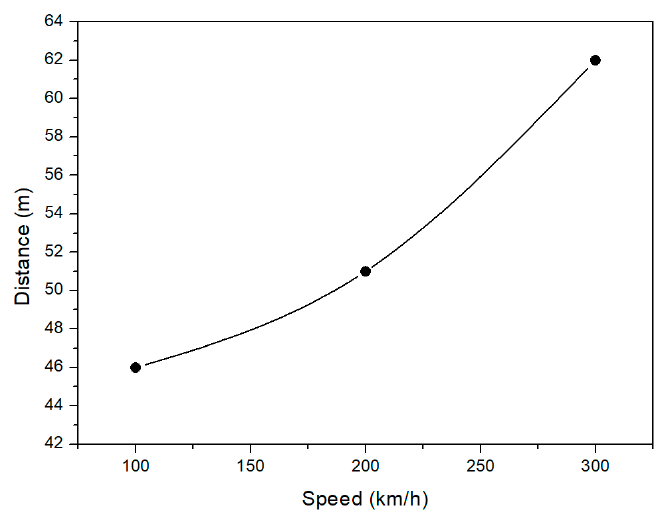
Figure 20. Distances between the point where the impact load occurred and the bridge–earthwork boundary by train speeds.